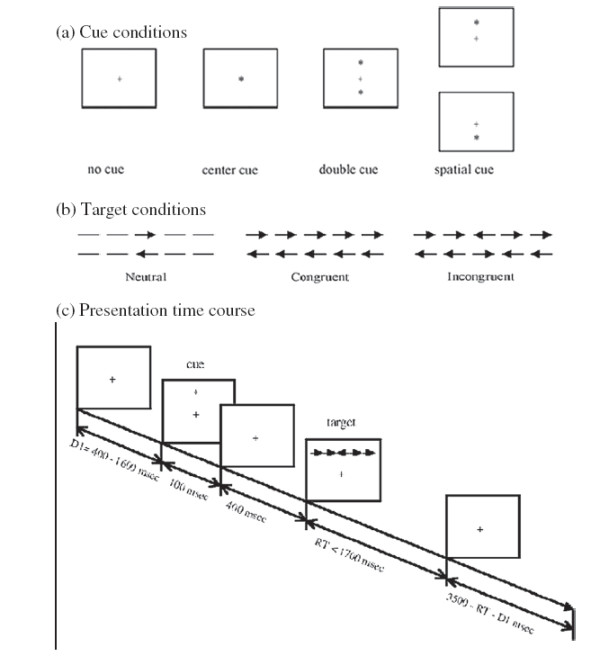
Experimental paradigm for the attention network test. (a) The four cue conditions. (b) The six stimuli used in the present experiment. (c) An example of the procedure and the time course of a trial using a spatial cue with incongruent flankers.